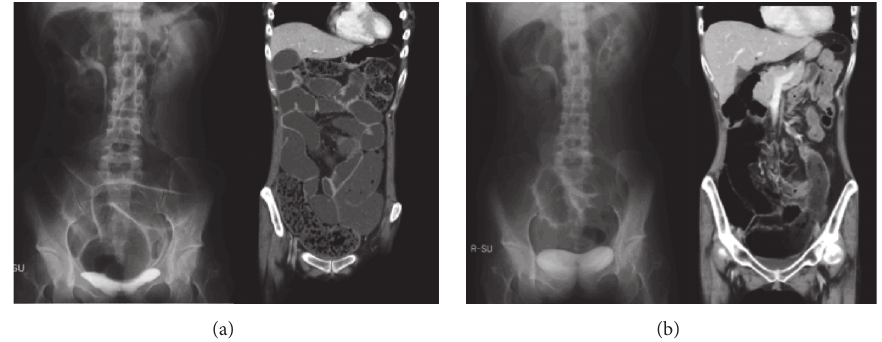
Figure 2: Abdominal radiography and CT findings at the emergent admission (a) and after treatment with octreotide (b). (a) Multiple and dilated small and large bowels with air-fluid levels in bowel loops (X-ray) and huge distention of bowel without mechanical obstruction (CT). (b) Thickening of the bowel wall and dilation of the bowels with air-fluid levels were